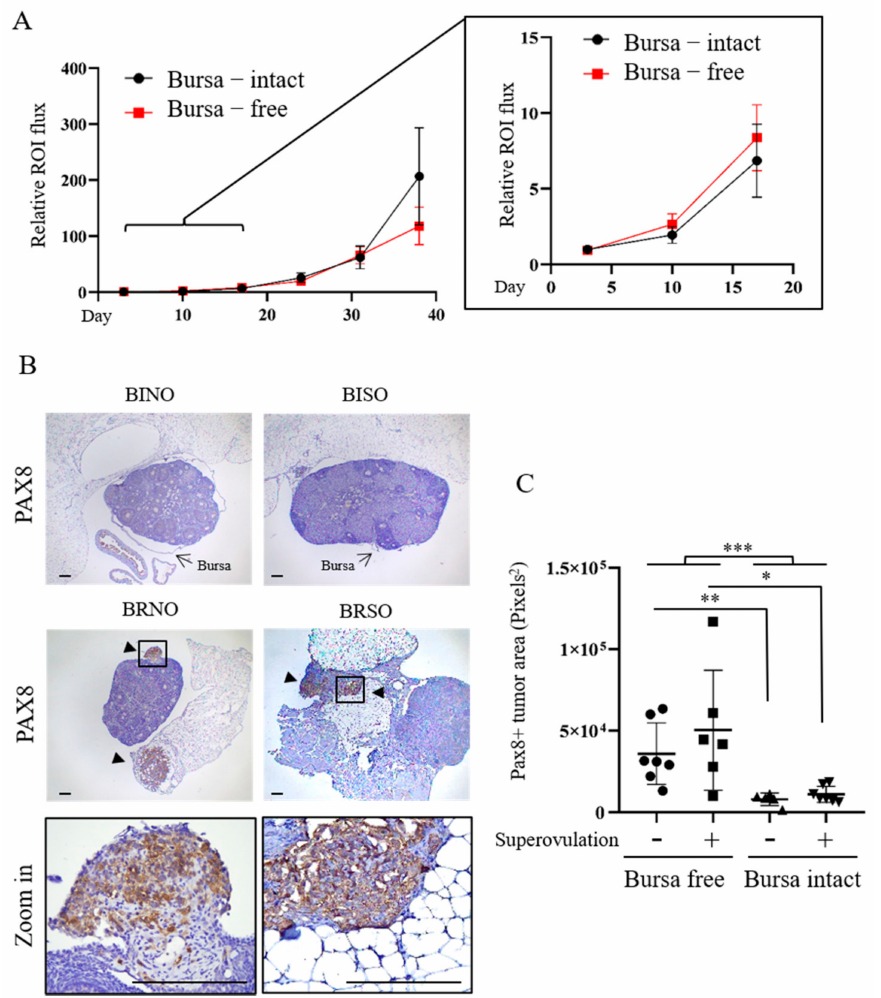
Figure 2. The bursa-free state disclosed the ovarian homing of transformed FTE cells from the peritoneal cavity. ( A ) Mean ( ± SEM) intraperitoneal IVIS flux in the region of interest (ROI) at different time points in 7 bursa-intact and 11 bursa − removed normal ovulation mice. ( B ) Examples of PAX8 − expressing periovarian lesions examined in the seventh week. ( C ) Areas of PAX8(+) lesion in randomly sampled tubo − ovarian tissues from different mouse groups, as described in Materials and Methods. * p < 0.05, ** p < 0.01, *** p < 0.001 by two − sided, unpaired Student’s t